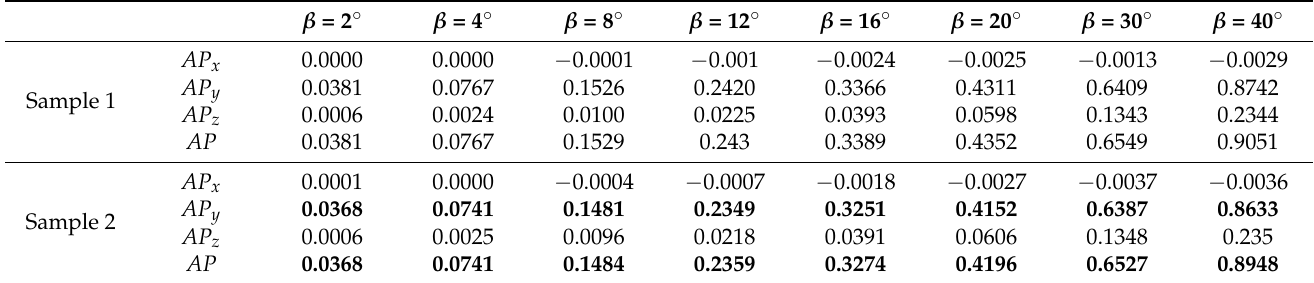
Table 4. Positioning accuracy AP [mm] components for Probe 1 ( ∅ 2 mm).